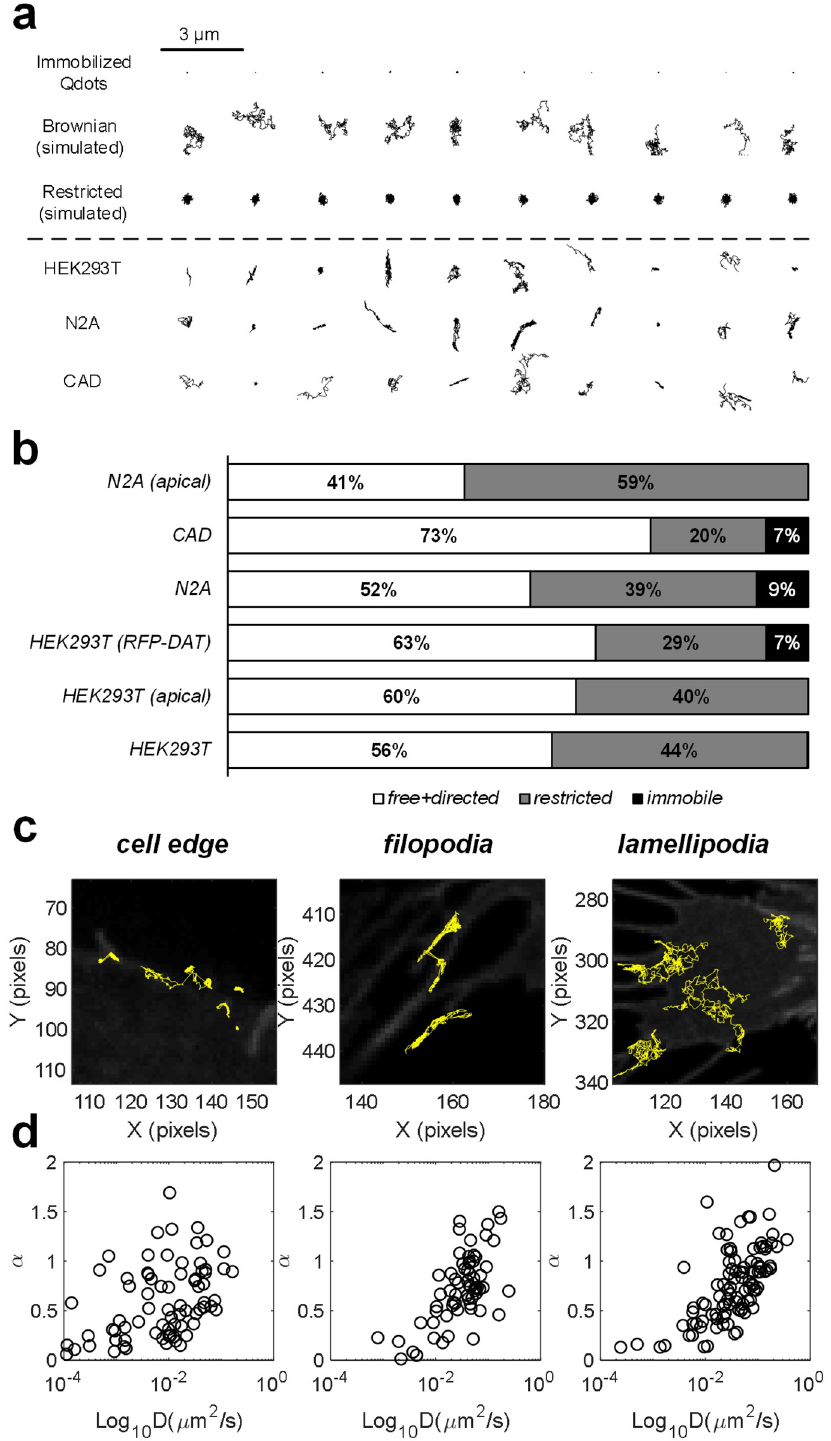
Fig 2. Analysis of DAT-Qdot diffusive heterogeneity at the single trajectory level. (a) A set of 10 random trajectories is shown for both simulated Brownian and restricted type of motion as well as experimentally acquired spin-coated (immobilized) Qdots and DAT-Qdots diffusing laterally at the surface of various cell hosts. (b) Classification of the type of motion of experimentally acquired DAT-Qdot trajectories using relative deviation analysis (HEK-293T/RFF-DAT: 2861 trajectories; HEK-293T/WT-DAT: 1236 trajectories; HEK-293T/WT-DAT on apical